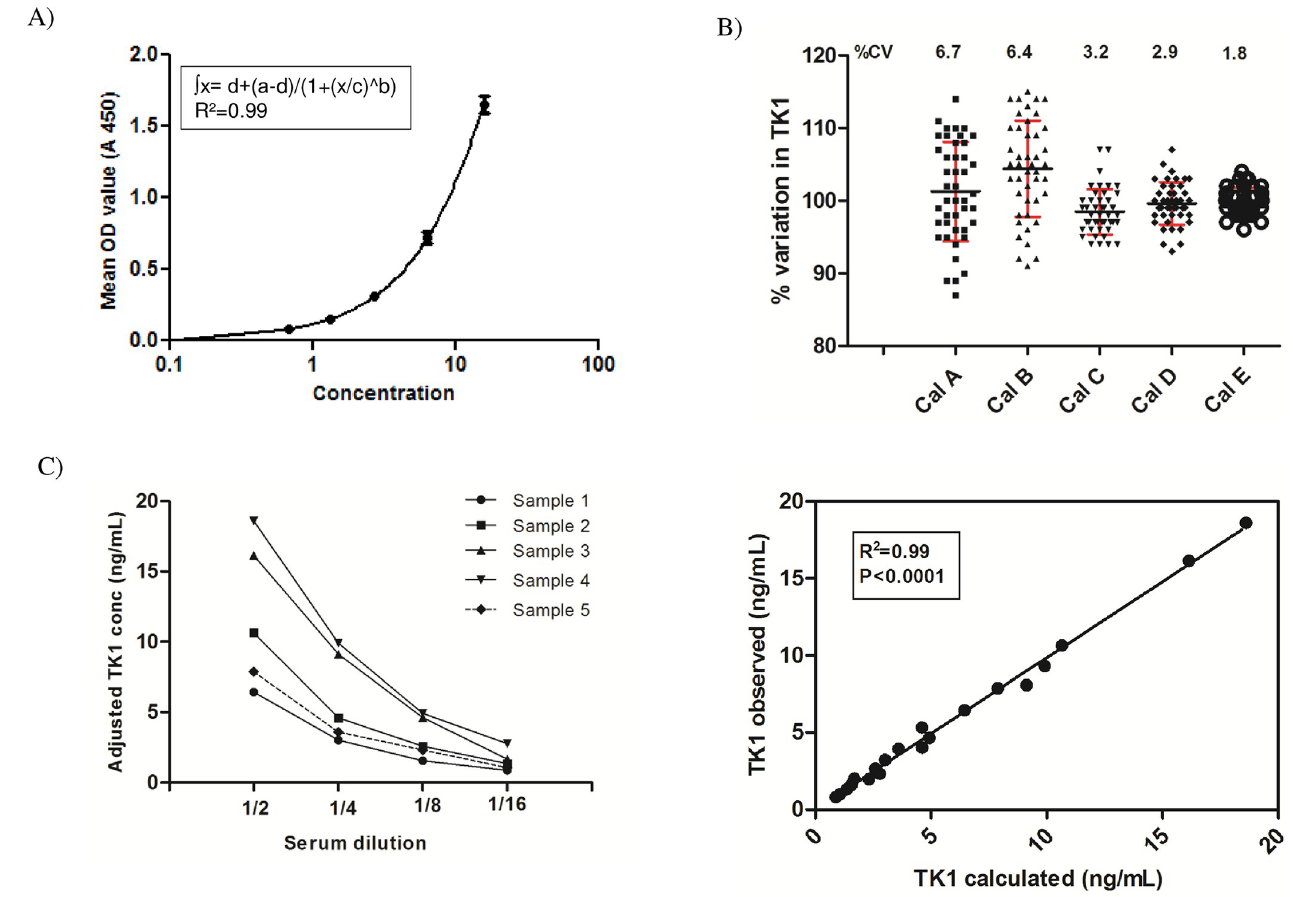
Fig 2. TK 210 ELISA standard curve and assay linearity. (A) A standard curve for TK 210 ELISA with calibrators (0–18 ng/mL) using 4-PL (non-linear regression program) in Graph pad prism. The limit of detection was 0.12 ng/mL. The error bars indicate the mean and standard deviation (SD) of 10 different experiments performed in duplicate. (B) The percentage change in calibrators from the precision assays. The error bars indicate the mean and standard deviation (SD) value of the calibrator. (C) The OD values of serially diluted serum samples measured by AroCell TK 210 ELISA. (D) The correlation between expected and observed TK1 protein levels in serially diluted